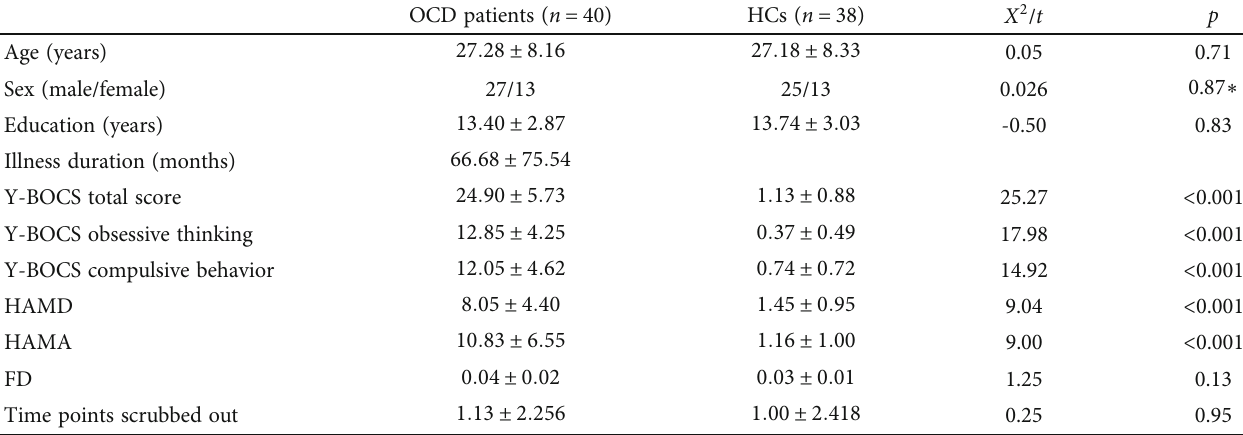
Table 1: Demographic and clinical characteristics of participants.